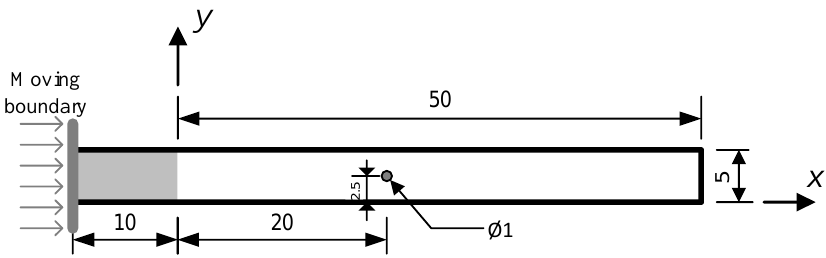
Figure 8. The sketch of the rectangular cavity with a circular obstacle (unit: mm). The simulated velocity magnitude, track line quantity, average number of entanglements Z ave and orientation degree S distributions of injection molding in the rectangular cavity with circular obstacle at times t = 1.62 × 10 − 3 s, 2.43 × 10 − 3 s, 3.33 × 10 − 3 s, 4.32 × 10 − 3 s and 4.95 × 10 − 3 s are shown in Figure 9a–d, respectively. The animations corresponding to the above results can be found in Supplementary Material Figures